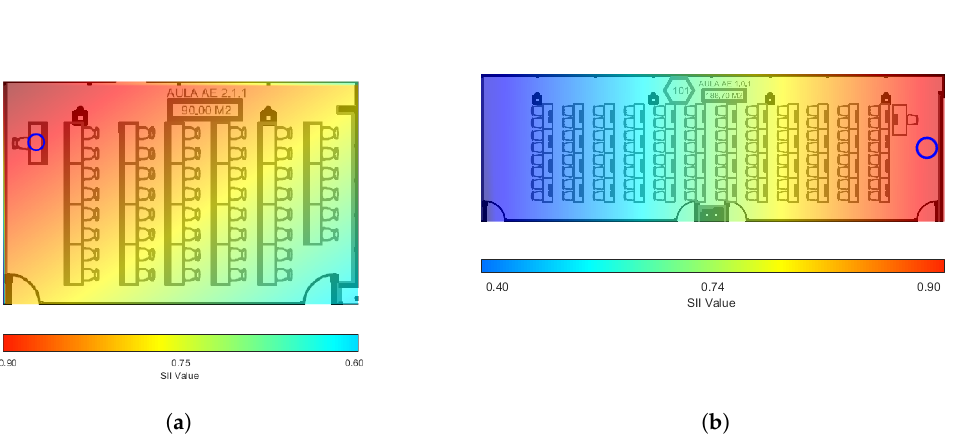
Figure 8. Heat-maps of SII measurement mappings in different rooms at the ETSE (( a ). Classroom 2.1.1 and ( b ). Classroom 1.0.1). Marked position of sound source node (blue cicle). The values obtained represent accurately the perception of speech in the rooms